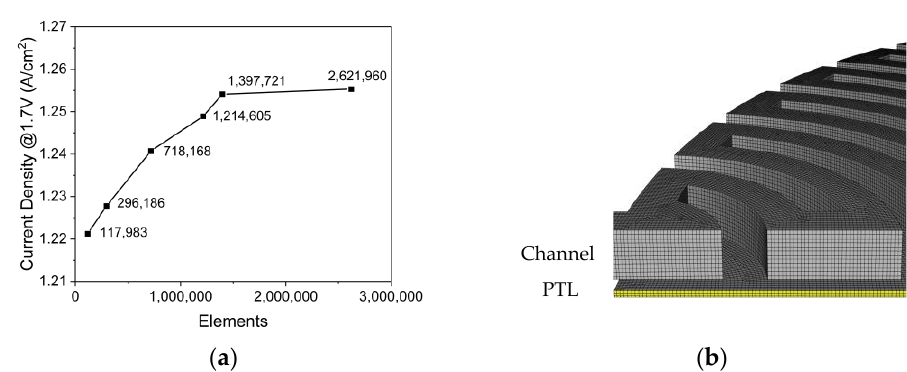
Figure 5. ( a ) Results of the grid independence test of the PEMWE model and ( b ) channel and PTL grids used in the PEMWE simulation ( W Ch : 2 mm, W Rib : 2 mm, H Ch : 2 mm, ε : 0.75, K : 30.2 × 10 − 12 m 2 , θ : 30°, 𝑄̇ 𝑖𝑛 : 10 sccm, T in : 328.15 K, T cell : 328.15 K, V op : 1.7 V and 𝑔 : z+).